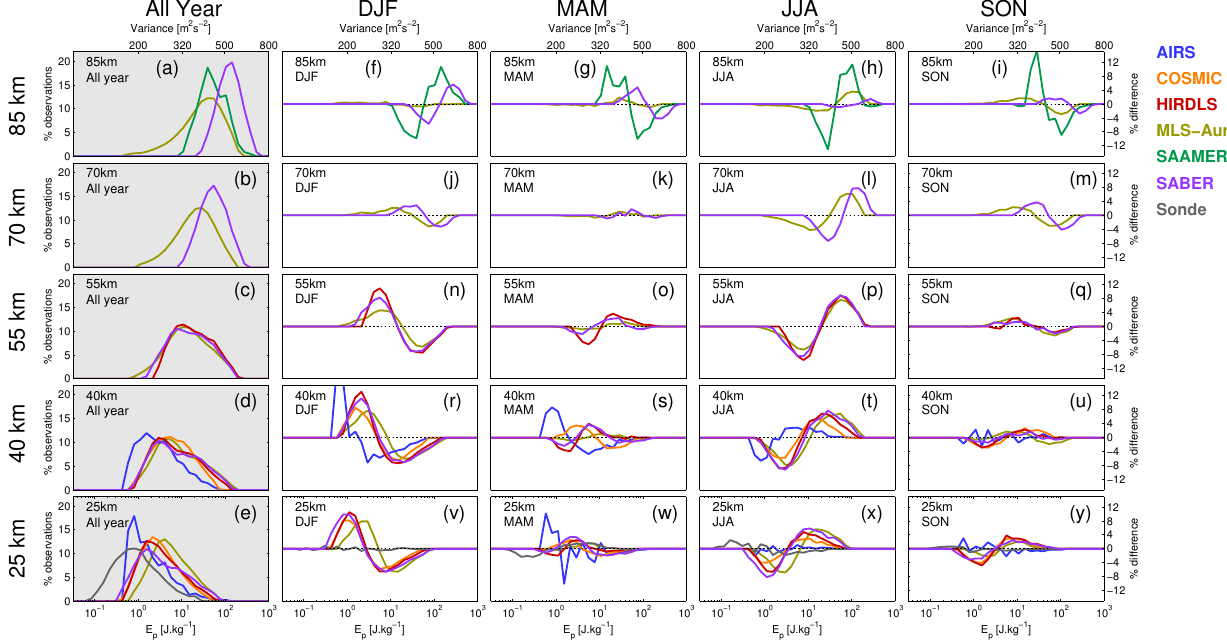
Figure 15. Percentage histograms of observed potential energies for all instruments at all levels. The leftmost column (a, f, k, p, u) shows histograms of all data considered, normalised to sum to 100%. Remaining panels show differences between the normalised distribution for each season and the annual mean normalised distribution at that high level, as a percentage difference. SAAMER variances use the top horizontal axis; all other histograms use the bottom horizontal